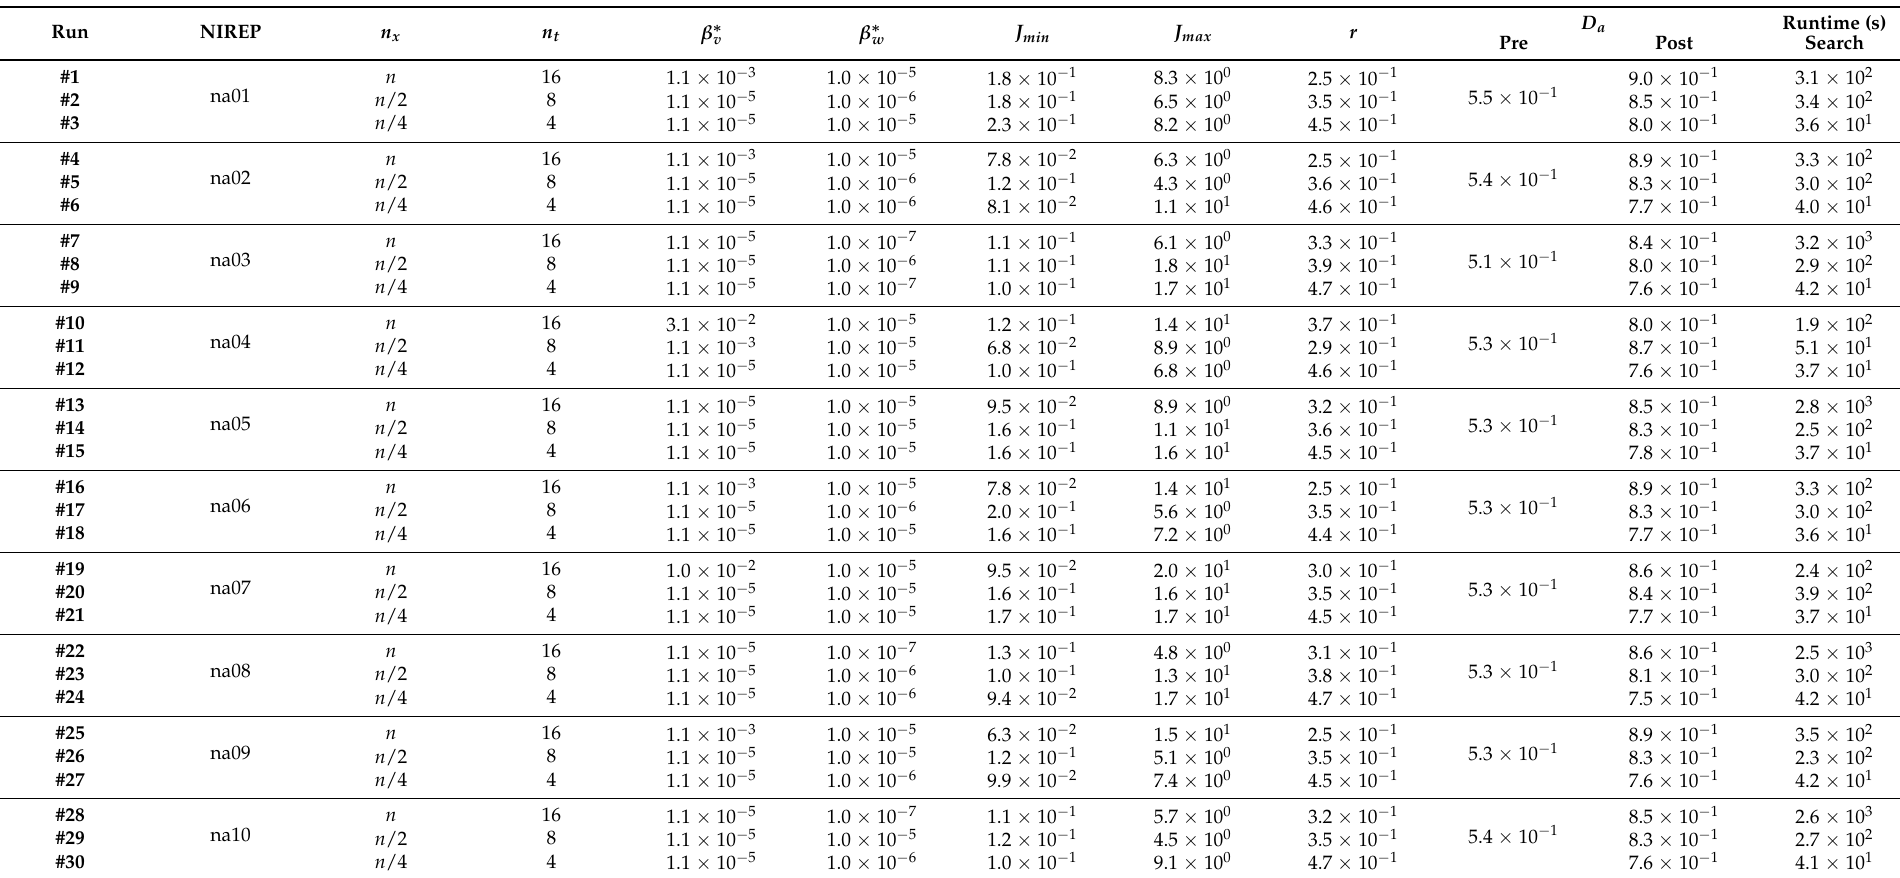
Table 7. Experiment 2B: Registration performance for CLAIRE for case 1 ( n t changes proportional to the image resolution) . Comparison of registration accuracy using Dice and relative residual r at different resolutions for the registration of the MRI250 brain image to templates generated from ten real MRI scans from the NIREP dataset. We consider three resolution levels n x = { n , n /2, n /4 } where n = ( 640,880,880 ) . We fix the tolerance for the relative gradient to 5 × 10 − 2 . We use linear interpolation in the semi Lagrangian scheme. The bounds for the determinant of the deformation gradient for the parameter search are [ 0.05,20 ] . We report the regularization parameters β ∗ v and β ∗ w obtained through the proposed parameter search scheme, the minimum and maximum determinant of the deformation gradient ( J min and J max ), the relative residual ( r ), the average Dice ( D a ), pre and post the registration, as well as the wall clock time for the parameter